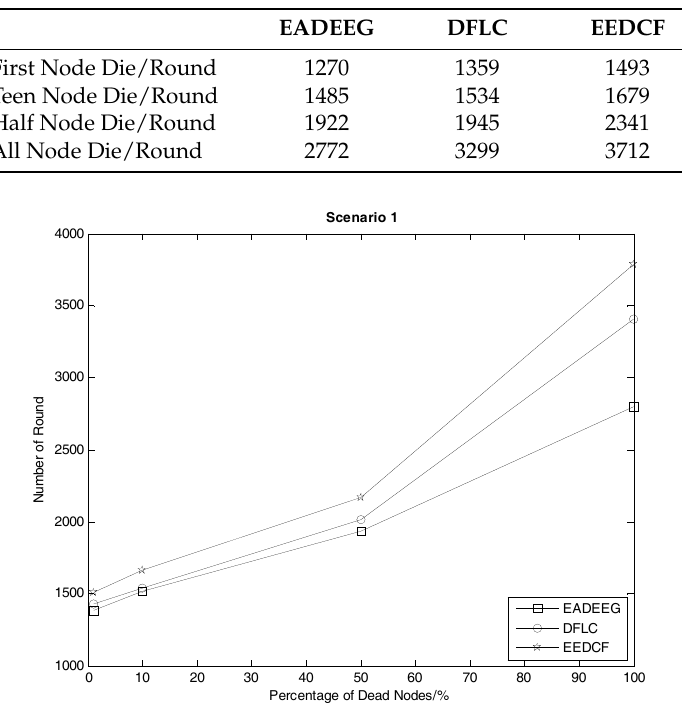
Figure 9. Number of round corresponding to different proportions of dead nodes of the network in Scenario 1.